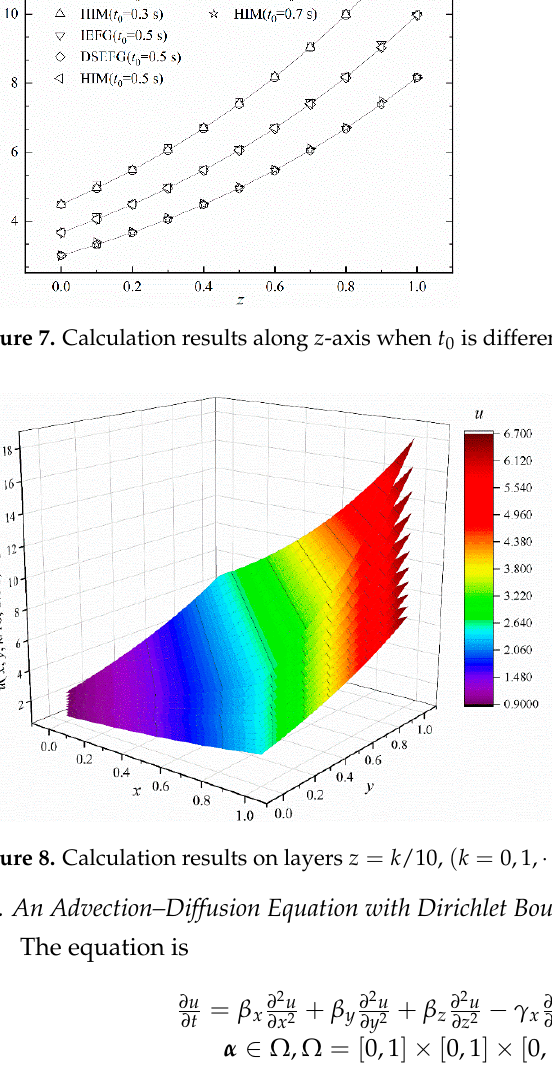
The boundary conditions